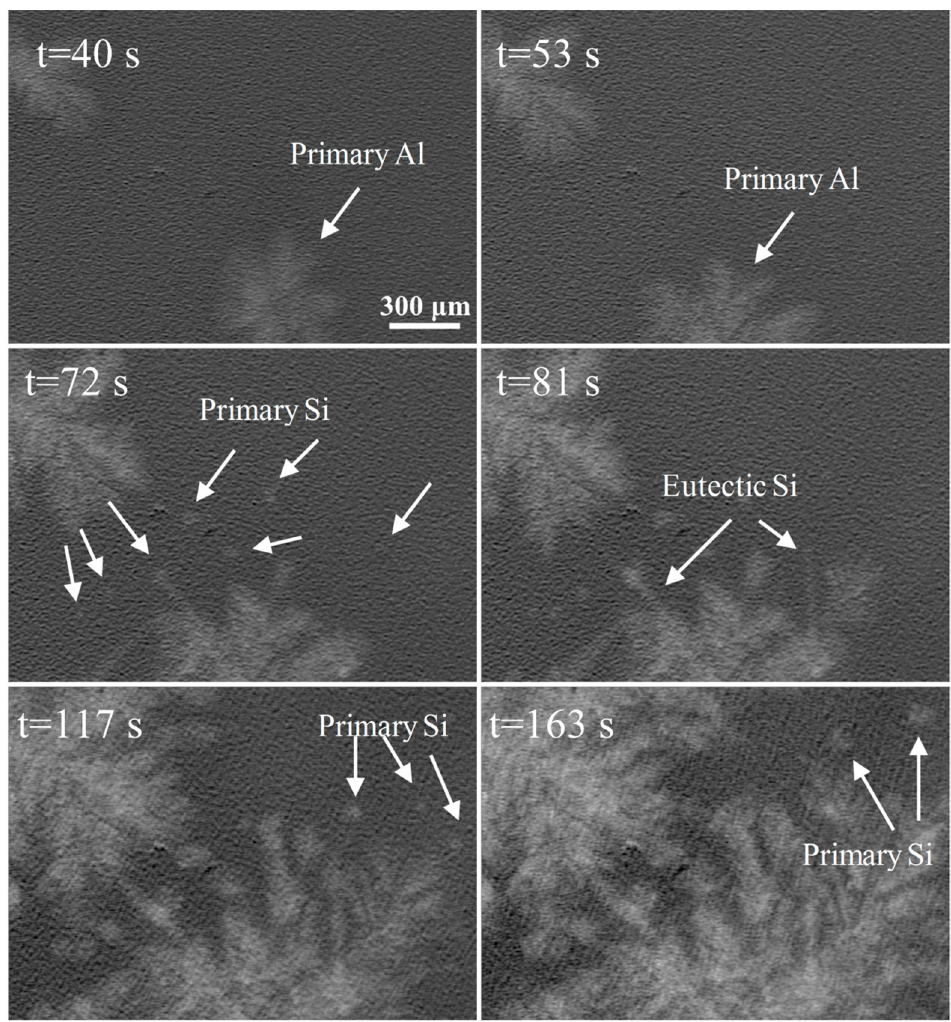
Figure 12. The series of radiographs at different times showing the solidification sequence of high- purity Al-40Zn-5Si alloy with the addition of 20 ppm P.